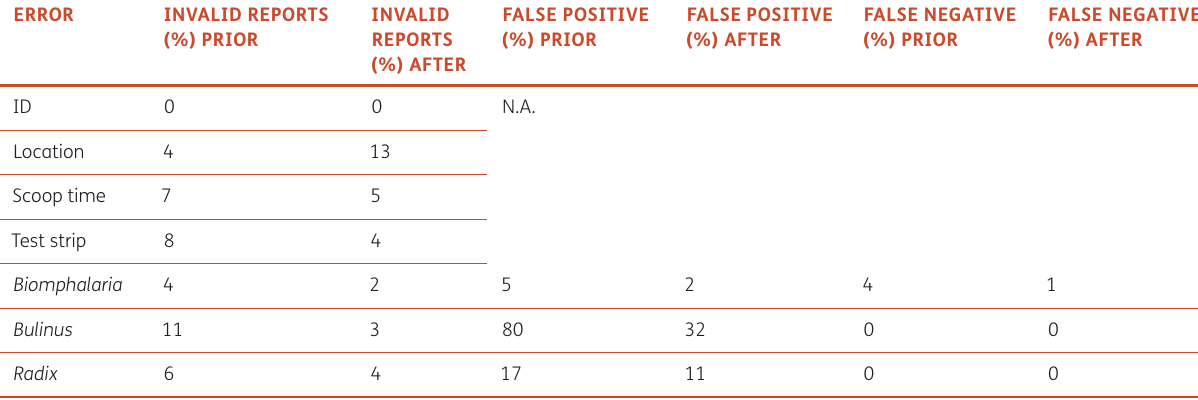
Table 2 Overview of the validation results showing the percentage of reports containing a specific error, both before and after the personalized feedback. For the identification of the three snail genera of interest, the percentages of false positive and false negative reports are also provided. (n = 570).